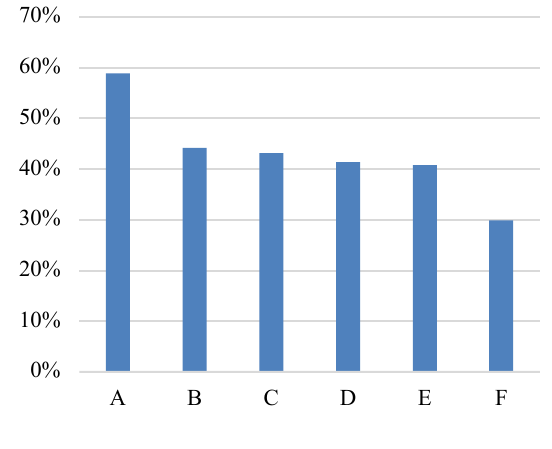
Fig. 8. CE expected troubles.